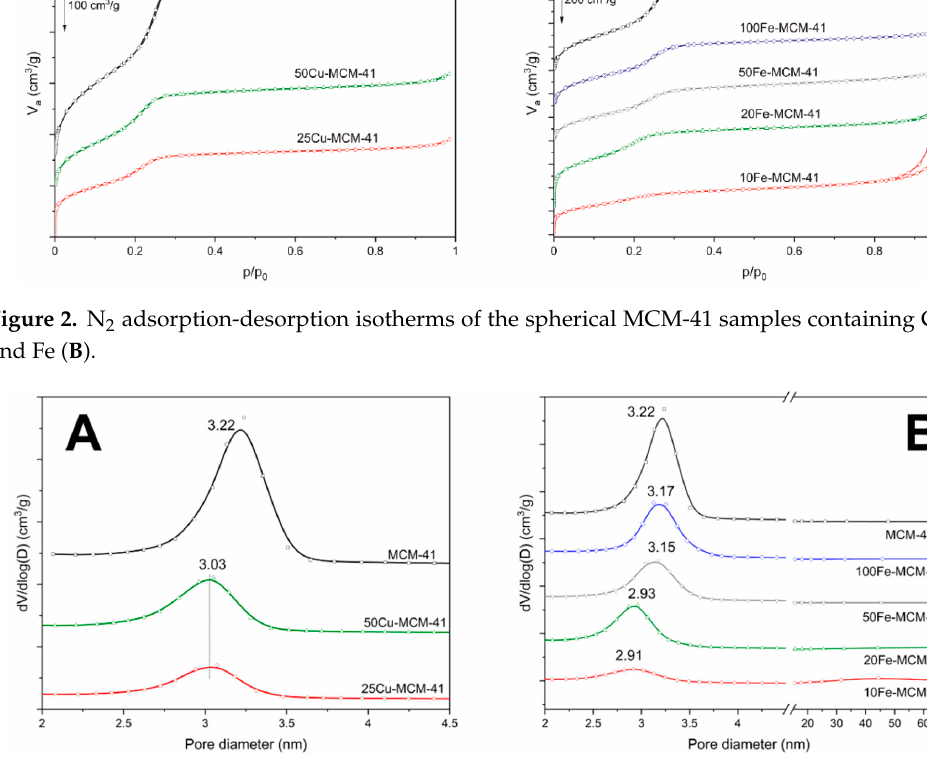
Figure 3. Pore size distributions of the of the spherical MCM-41 samples containing Cu ( A ) and Fe ( B ). Table 1. Textural parameters, chemical composition and surface acidity of the spherical MCM-41 samples. Sample